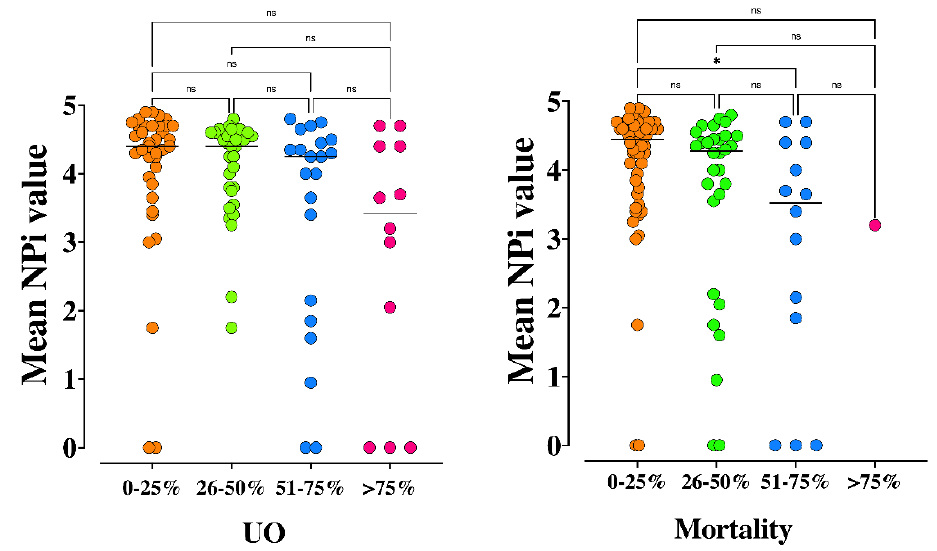
Figure 5. Mean Neurological Pupil Index (NPi) values across different predicted 6-month unfavorable neurological outcome (UO, p = 0.04) and mortality ( p = 0.02) according to the TBI-IMPACT database. * p < 0.05 for post hoc analysis among groups. NS = not statistically significant. The Kruskal Wallis test, with Dunn-Bonferroni post hoc analysis, was used.